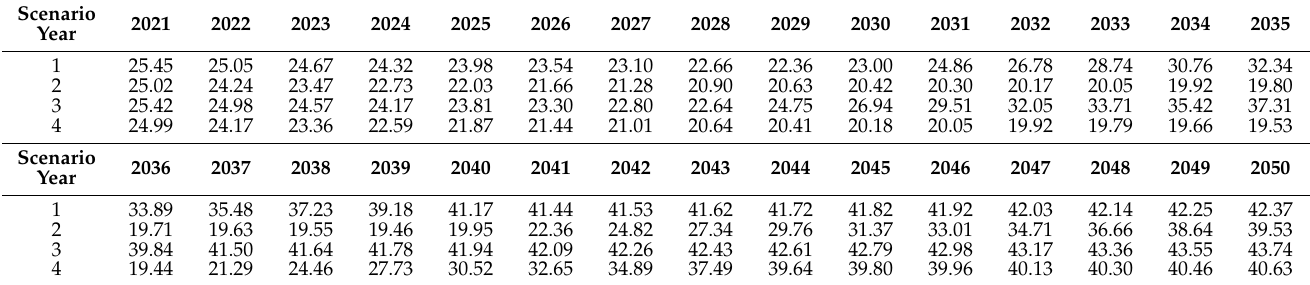
Table 5. The WRSVD of Zhongshan City in the four